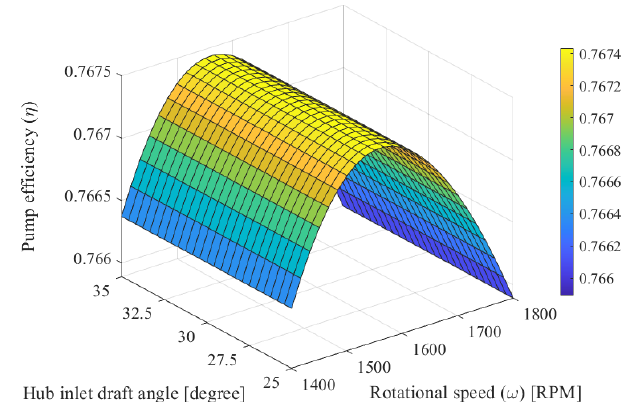
Figure 3. Variation of pump efficiency with rotational speed and hub inlet draft angle.